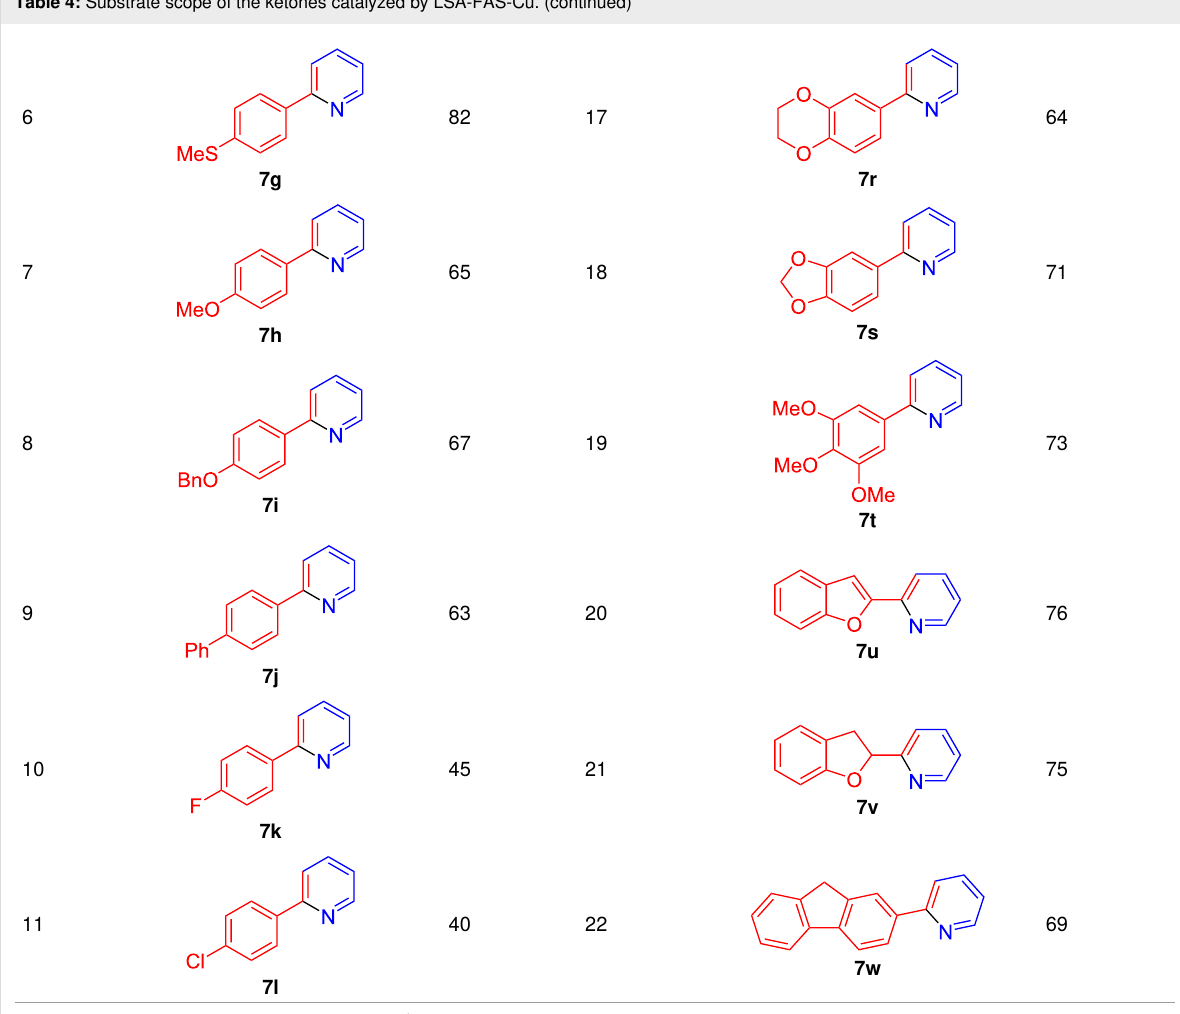
Table 4: Substrate scope of the ketones catalyzed by LSA-FAS-Cu.